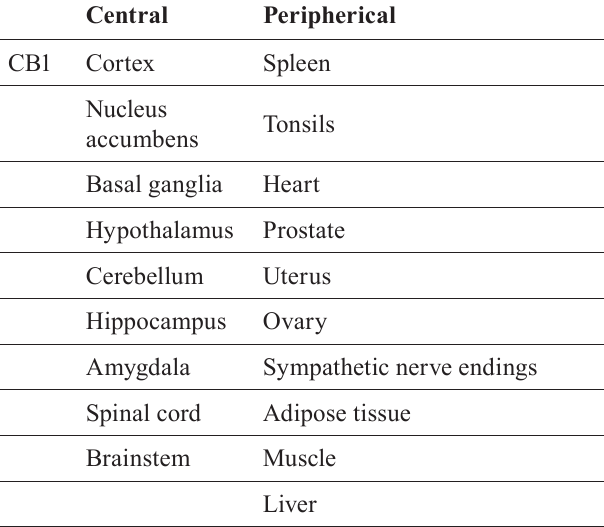
TABLE VI - CB1 and CB2 distribution in the organism (Howlett, Abood, 2017; Cassano et al. , 2020)